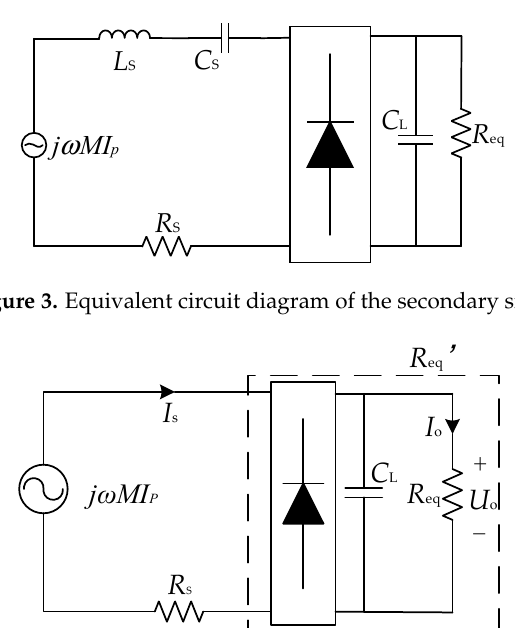
t 2 t 2 t 2 Figure 2. Charging characteristic curve of battery.